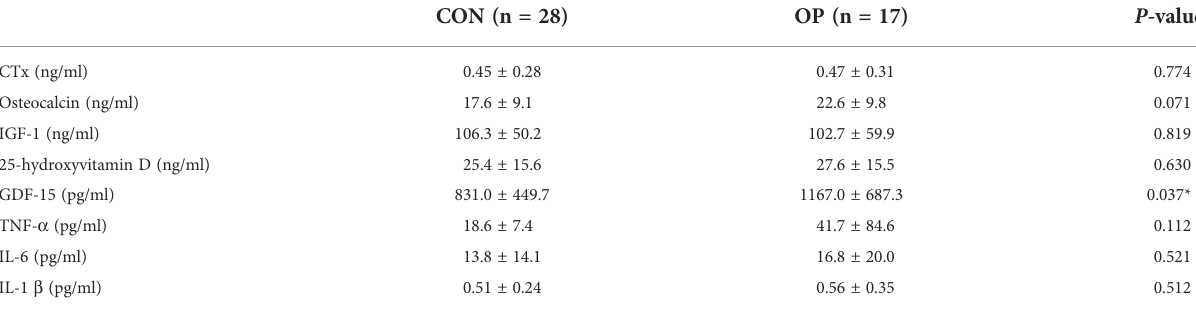
TABLE 3 Differences of serum levels of bone turnover markers, IGF-1, vitamin D, GDF-15, and in fl ammatory cytokines between CON and